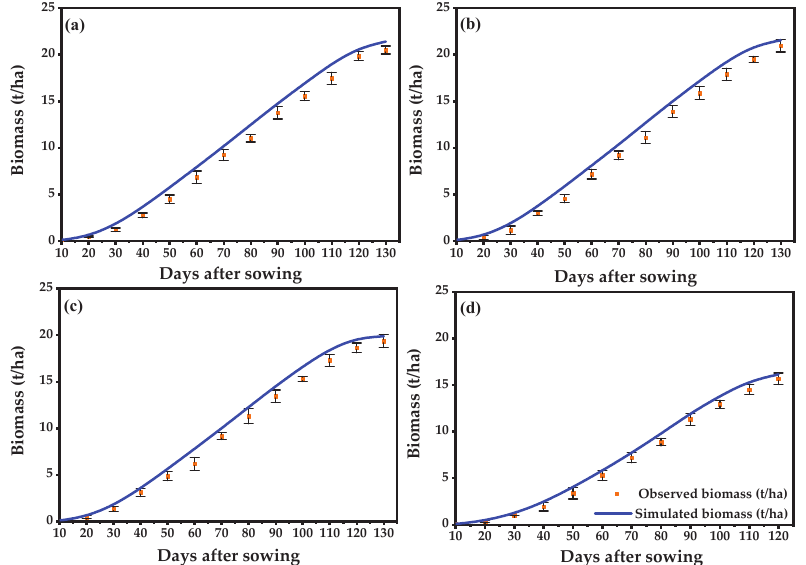
Figure 8. Observed and simulated average biomass during the calibration period (2019) under four irrigation regimes. FI, flood irrigation ( a ); 3IF, 3-day irrigation frequency ( b ); 6IF, 6-day irrigation frequency ( c ); and 10IF, 10-day irrigation frequency ( d ). Error bars indicate standard deviation among the three replicates.